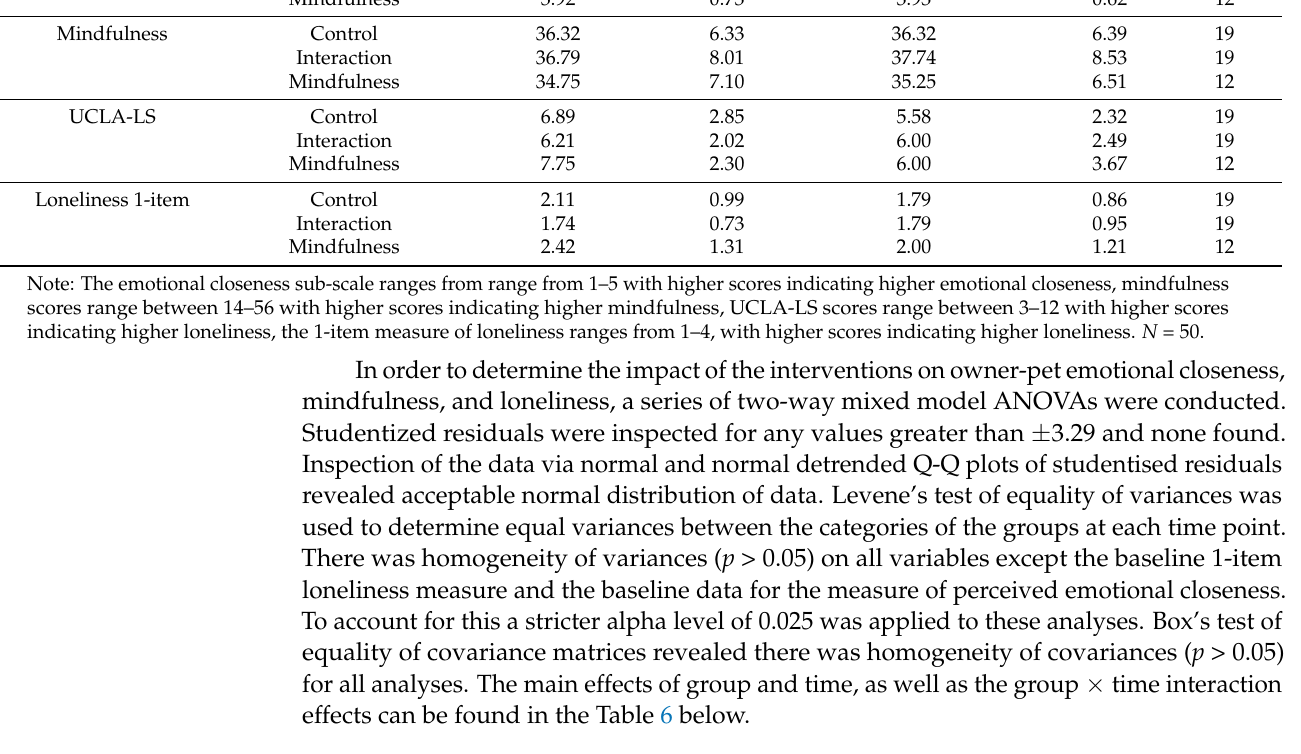
Table 6. Mixed methods ANOVA results for group, time, and group × time interaction